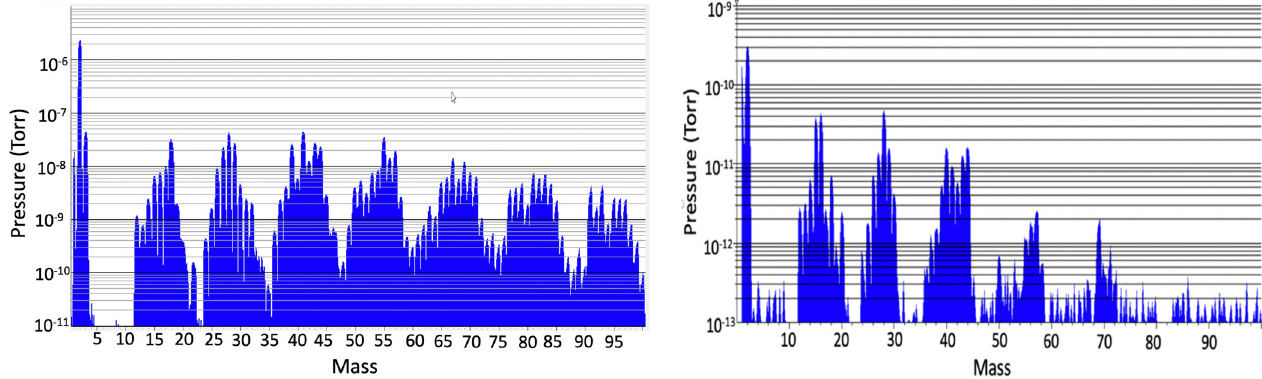
FIG. 3. Left: early gun RGA spectrum showing significant hydrocarbon contamination. Right: improved gun vacuum at nominal cw rf power after NEG